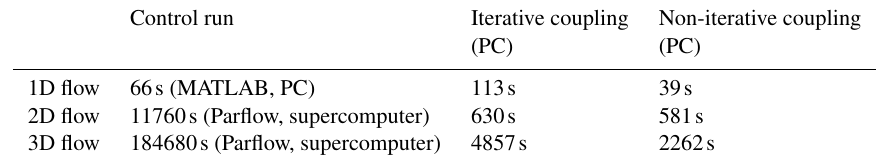
Table 4. Wall clock times for the different test cases and coupling schemes.